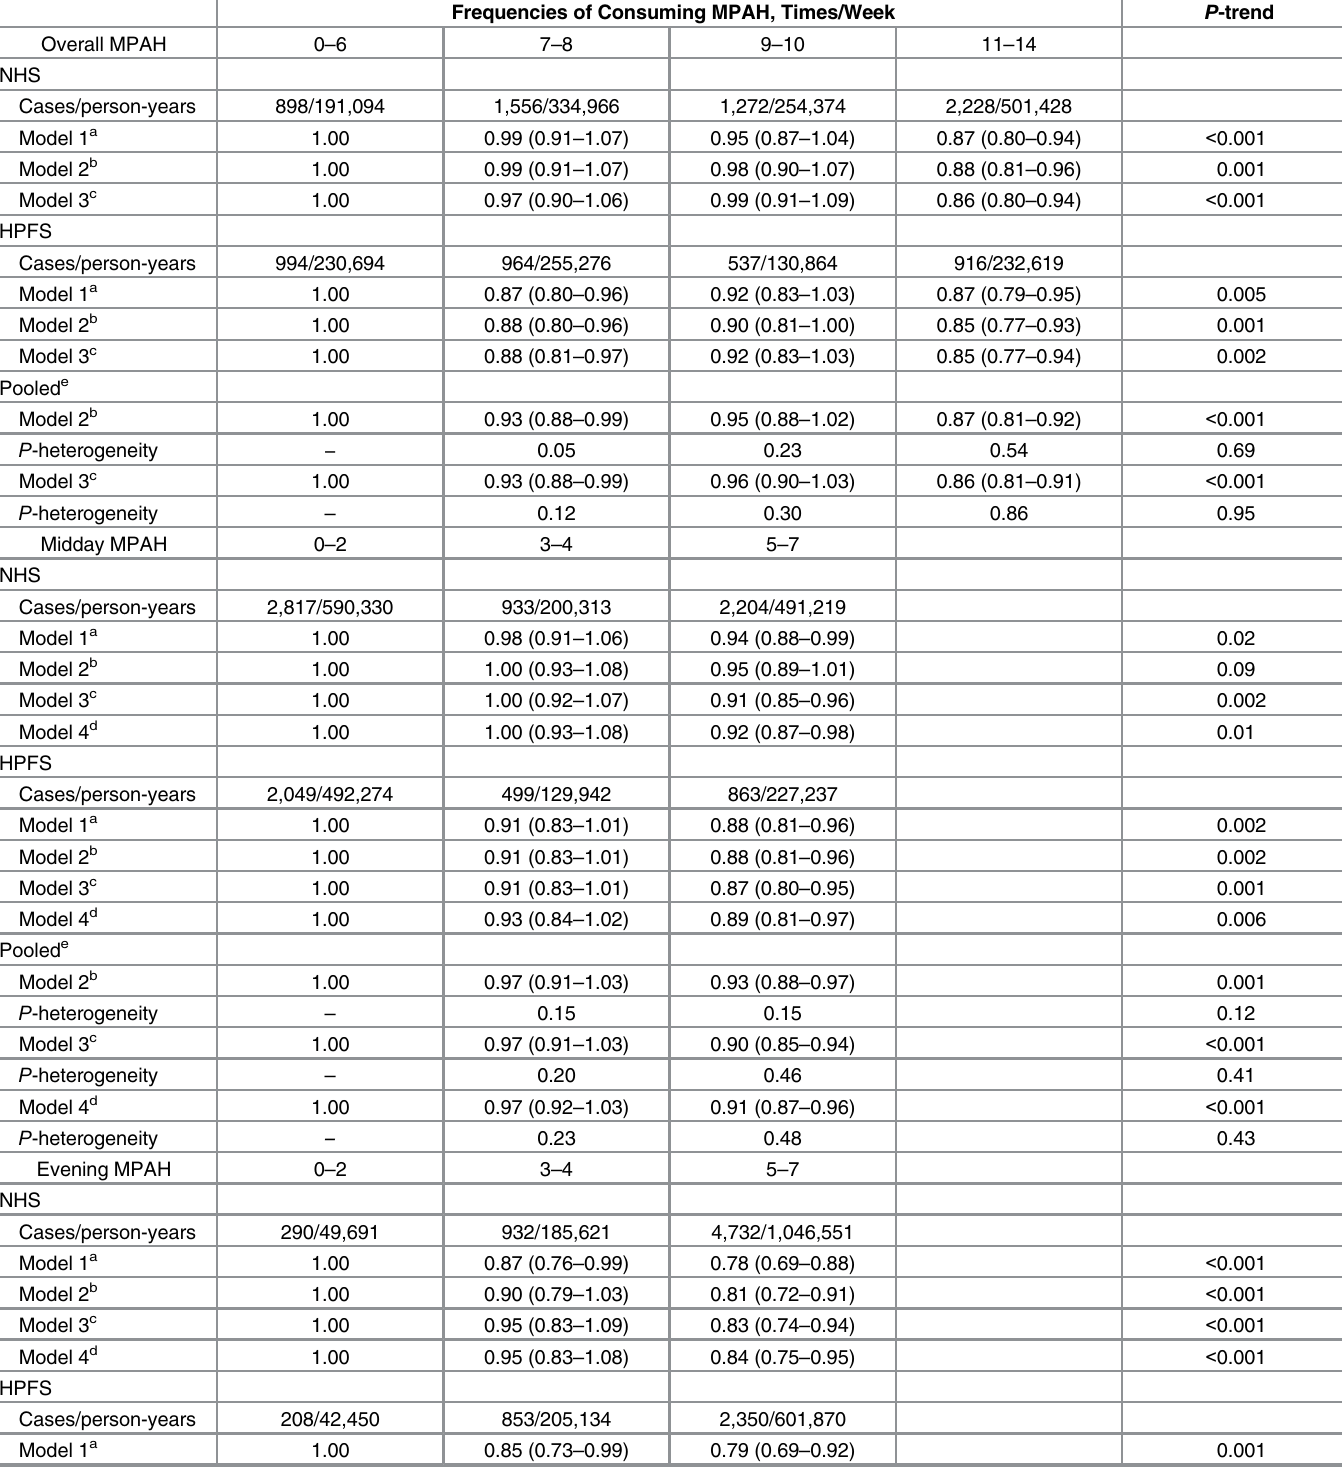
Table 2. Hazard ratios (95% confidence intervals) of type 2 diabetes according to frequencies of meals prepared at home in the Nurses ’ Health Study (1986 – 2010) and the Health Professionals Follow-up Study (1986 –